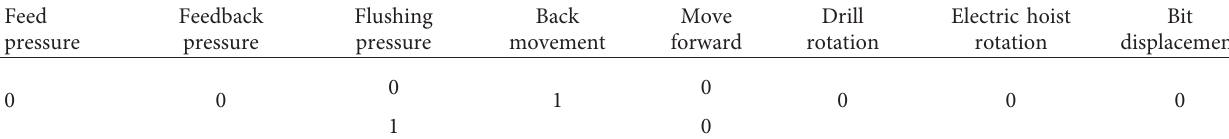
Table 2: The status of each working parameter during the forward movement of the rig.